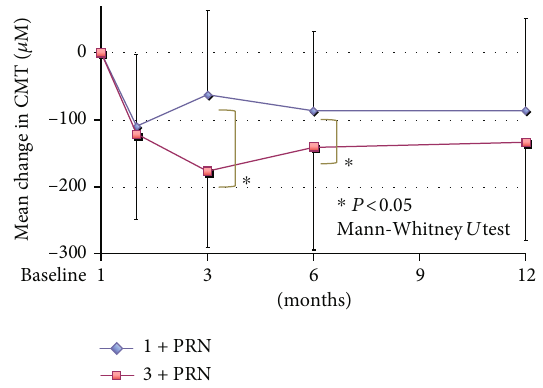
Figure 2: Changes in the mean CMT from baseline to 12 months after the IVA. In the 3+PRN group, the mean CMT was signi fi cantly reduced at 3 and 6 months after the IVA compared to that in the 1+PRN group ( P < 0 : 001 and P = 0 : 013 , respectively; Mann-Whitney U test). However, there was no signi fi cant di ff erence in the mean CMT between the two groups at 12 months after the IVA. PRN: pro re nata ; CMT: central macular